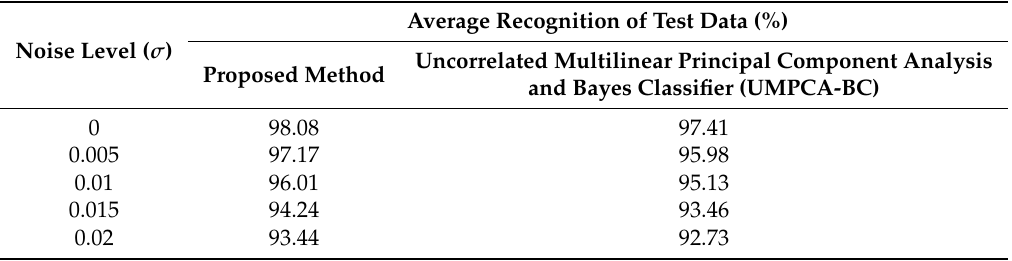
Table 5. The performance comparison for various noise